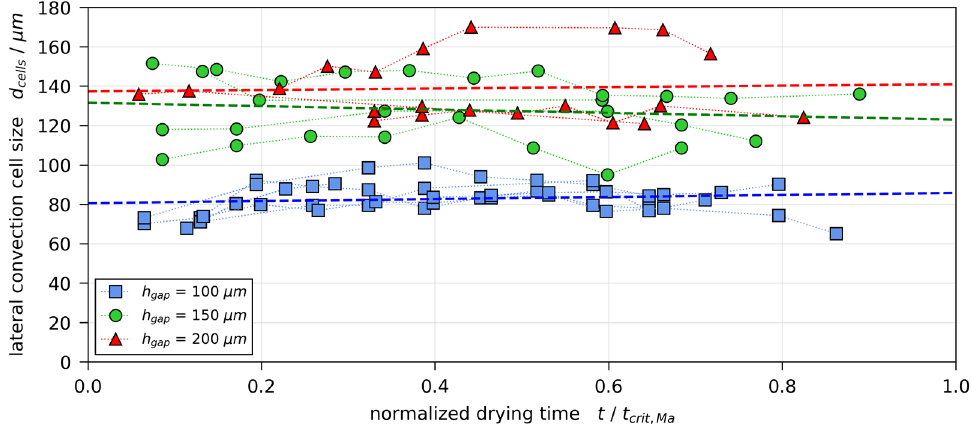
Figure 9. Transient lateral convection cell size from films with an initial solvent load of X 0 = 2 g MeOH / g PVAc and different initial film heights ( h gap = 100, 150, and 200 µ m ). Each set of markers indicate experimental results of a single cell (see Figure 8, red circles), while the dashed lines are the respective linear fits.